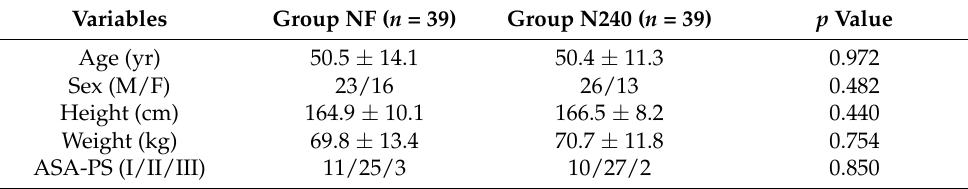
Table 1. Demographic data and intraoperative variables.